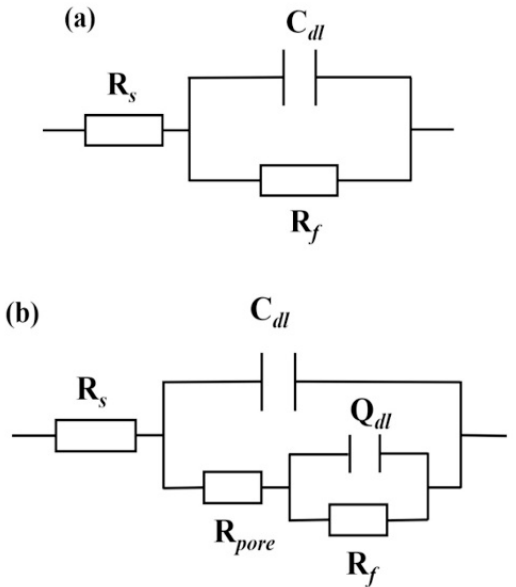
Figure 10. The equivalent circuit model used for fitting the EIS plots ( a ) substrate, ( b ) the borocarburized layer.